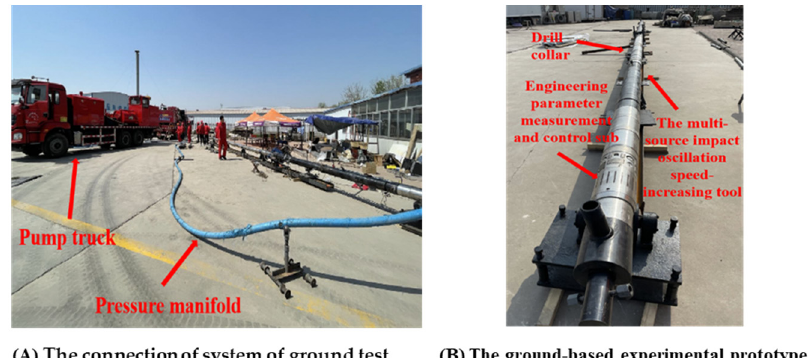
Figure 10. The system of the ground test.